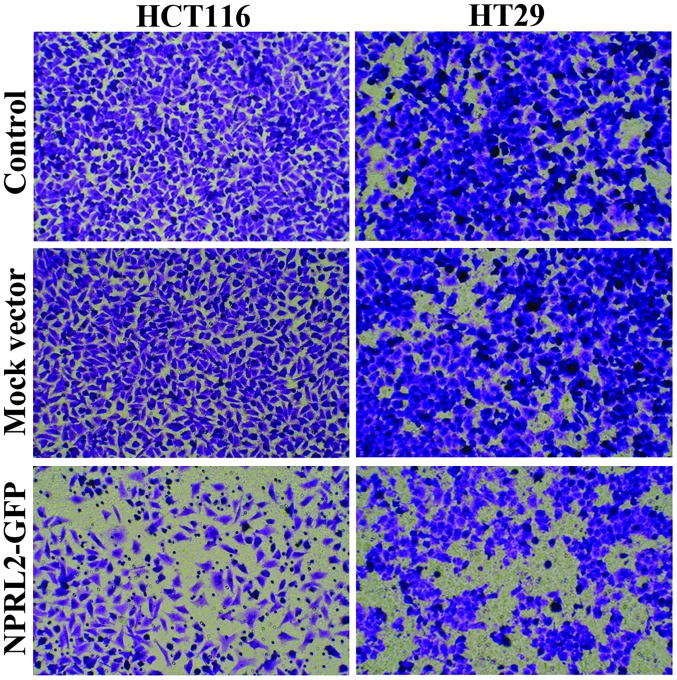
Inhibition of invasion by overexpression of NPRL2. Transwell assays were performed to analyze the effects of the overexpression of NPRL2 on the invasive potential of colorectal cancer cells. Attached cells in the lower section were stained with hematoxylin and eosin and counted using light microscopy (magnification, x200). Control, cells without transfection; mock, cells transfected with mock vector; NPRL2, cells transfected with NPRL2-overexpression vector. NPRL2, nitrogen permease regulator-like-2; GFP, green fluorescent protein.